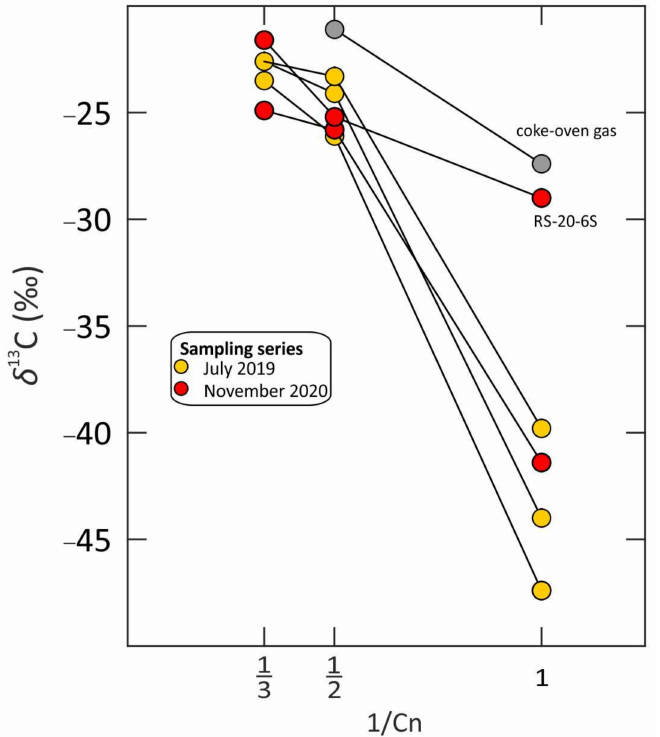
Figure 7. δ 13 C values of CH 4 , C 2 H 6 and C 3 H 8 versus the reciprocal of their carbon number (Cn) for studied gases. Order of δ 13 C values for CH 4 , C 2 H 6 and C 3 H 8 after Chung et al. [38].